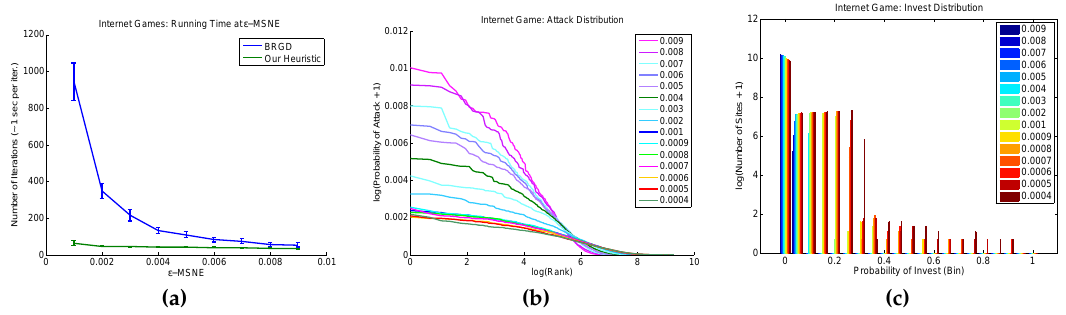
Figure 13. Properties of the Hybrid BRGD-Smooth Best-Response Dynamics (SBRD) Heuristic. BRGD vs. hybrid heuristic running time ( a ); Attacker’s attack ( b ) and sites’ ( c ) investment distribution on (cid:101) -MSNE.